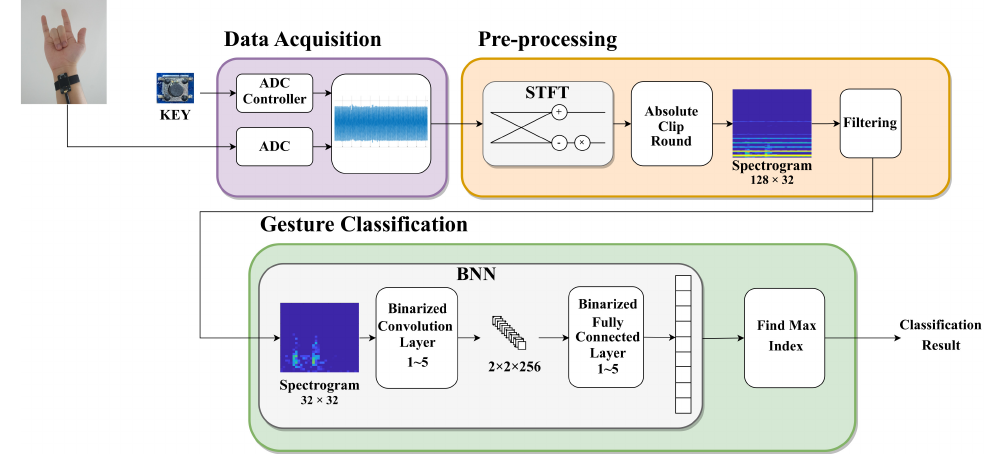
Figure 2. Overview of the proposed HGR